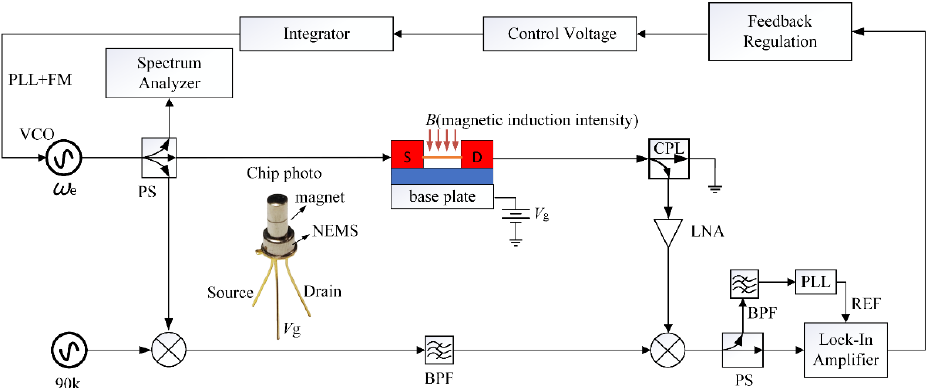
Figure 2. Closed-loop measurement and control system for ZnO NW resonator. VCO: signal generator (HP8648C, maximum FM voltage is ±1 V), PS: power divider, BPF: bandpass filter, LNA: low noise amplifier, ⊗ : mixer. V g : substrate voltage, used to apply a biasing force to the nanobeam. Directional coupler (CPL) selects ZEDC-15-2B; the coupling degree is 15 dB.